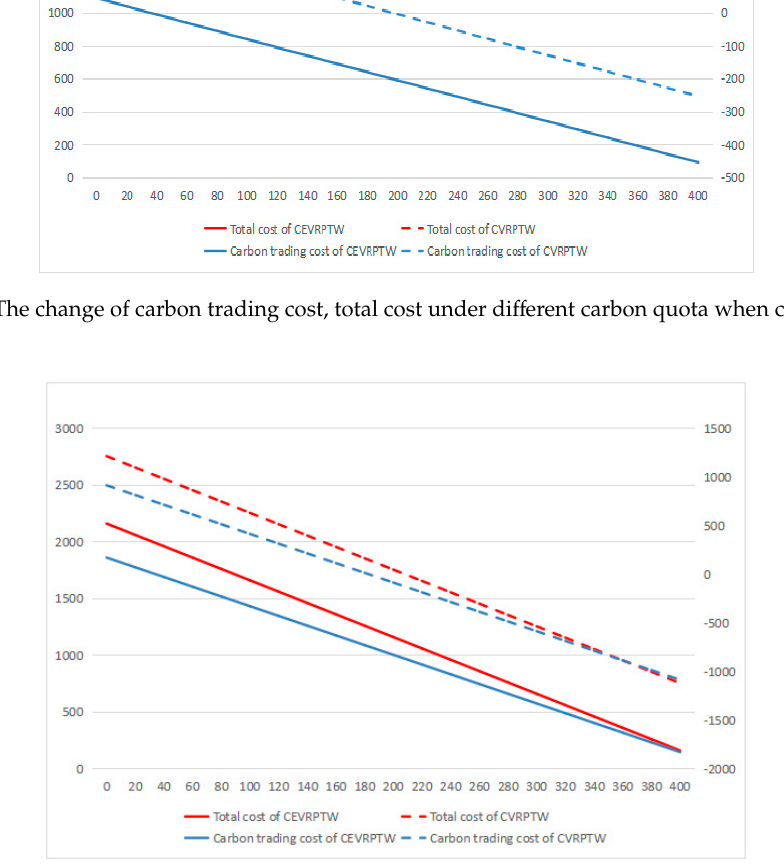
Figure 10. The change of carbon trading cost, total cost under different carbon quota when carbon price is 5.